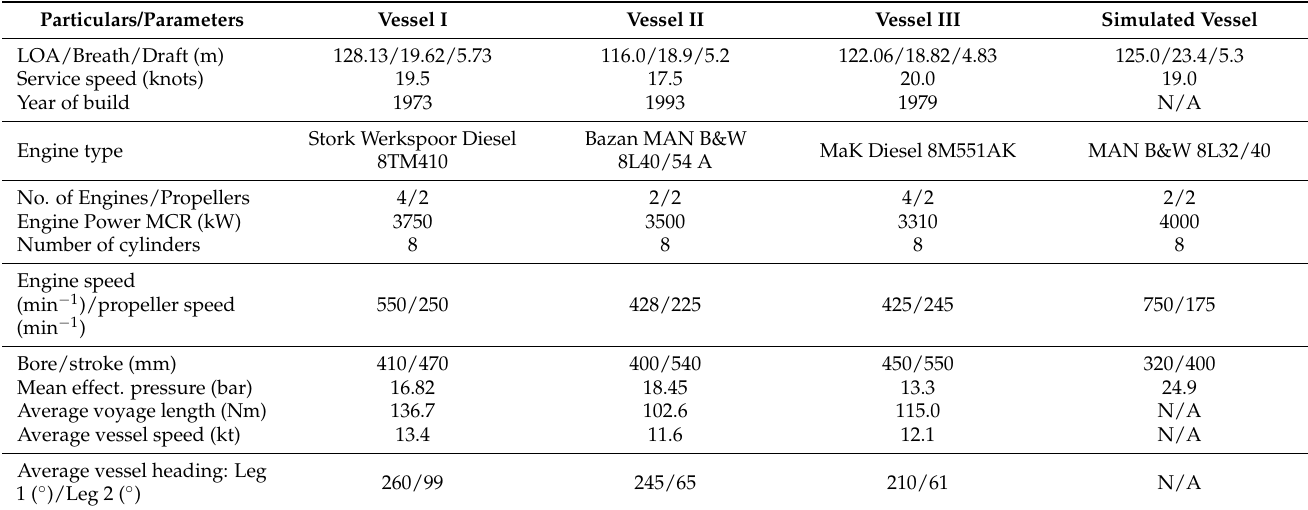
Table 1. Vessel and engine particulars/parameters.